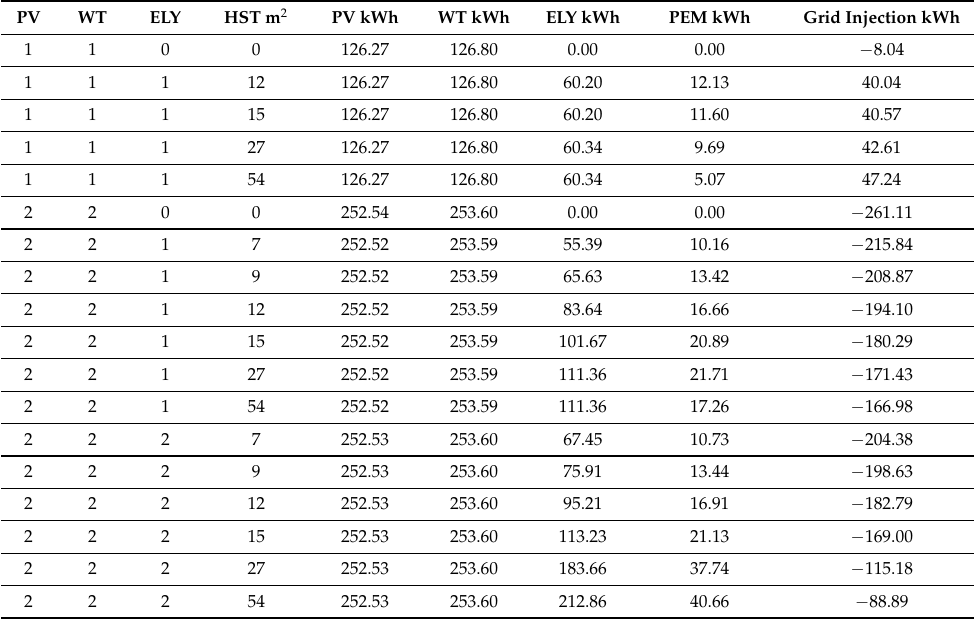
Table 7. Sensitivity analysis of hydrogen system performance with a real load